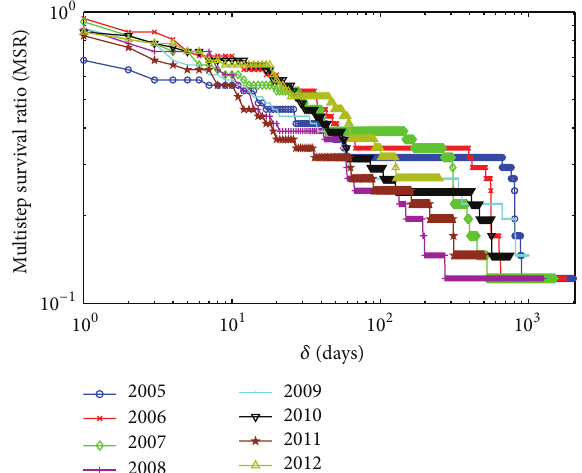
Figure 11: The multistep survival ratio (MSR) of MST of 42 currencies in the international FX market as a function of time for different initial time 𝑡 0 . For each curve, the initial time 𝑡 0 is the first